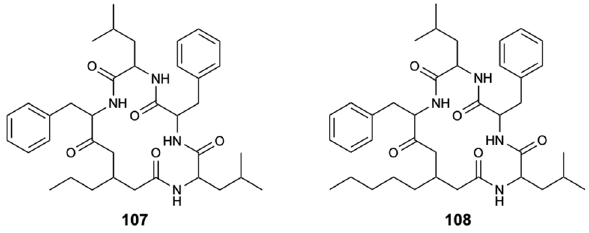
ffl ux pumps inhibitors: unnarmicin A ( 107 ) and unnarmicin C ( 108 Figure 27. Structures of efflux pumps inhibitors: unnarmicin A ( 107 ) and unnarmicin C ( 108 ). Figure 27. Structures of e